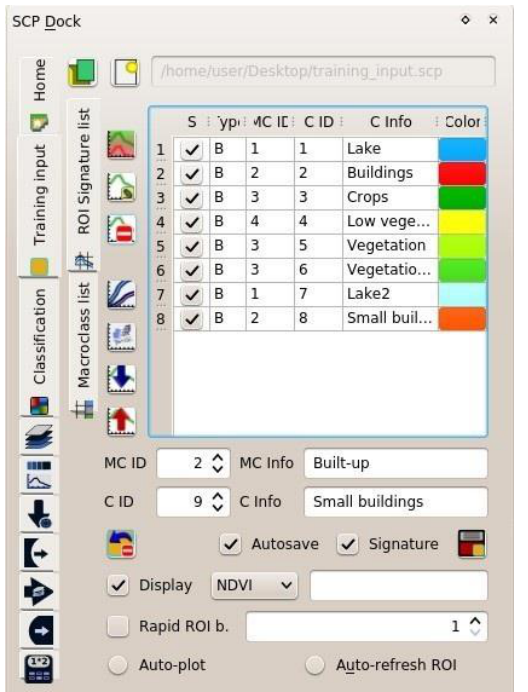
Figure 1. Definition of LC class colors using the SCP. Source: